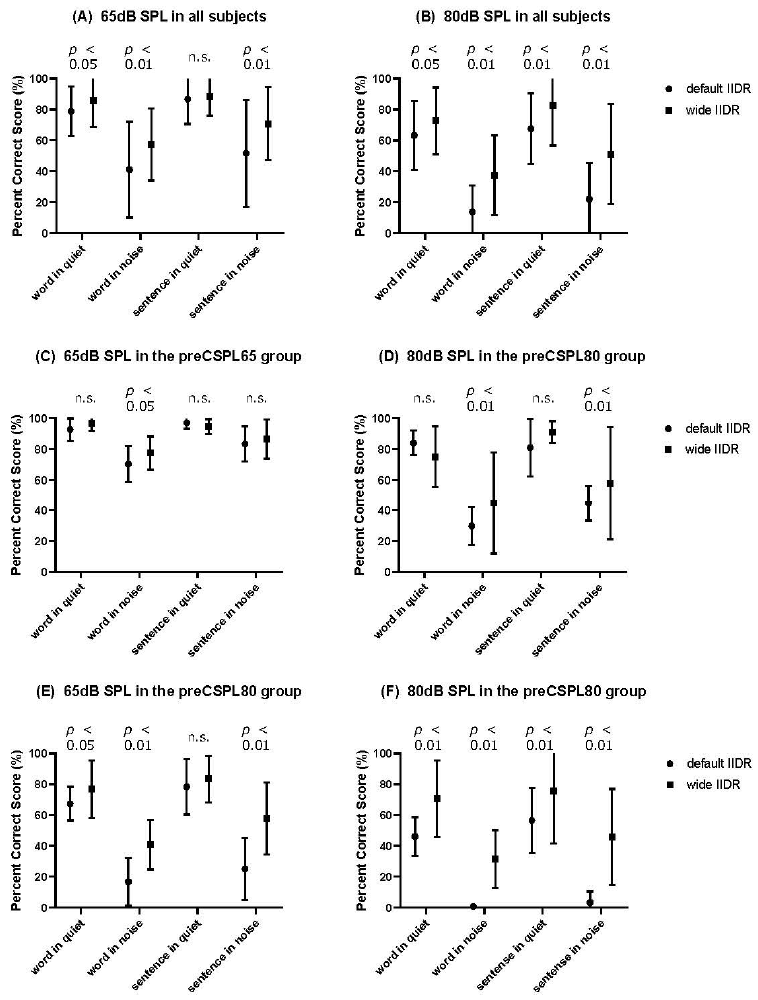
Figure 3. Percentage of correct word and sentence test scores in quiet and noise conditions presented at 65/80 dB SPL in ( A , B ) all subjects, ( C , D ) the preCSPL65 group, and ( E , F ) the preCSPL80 group. Mean scores of words in quiet, words in noise, sentences in quiet, and sentences in noise conditions were ( A ) 78.9%, 41.4%, 86.8%, 51.5%, ( B ) 63.3%, 13.8%, 67.5%, 22.0%, ( C ) 92.8%, 70.4%, 97.0%, 83.4%, ( D ) 84.0%, 29.6%, 81.0%, 44.6%, ( E ) 67.3%, 16.6%, 78.3%, 25.0%, and ( F ) 46.0%, 0.7%, 56.3%, 3.2%, respectively, with default IIDR, and ( A ) 85.8%, 57.5%, 88.6%, 70.9%, ( B ) 72.7%, 37.5%, 82.6%,